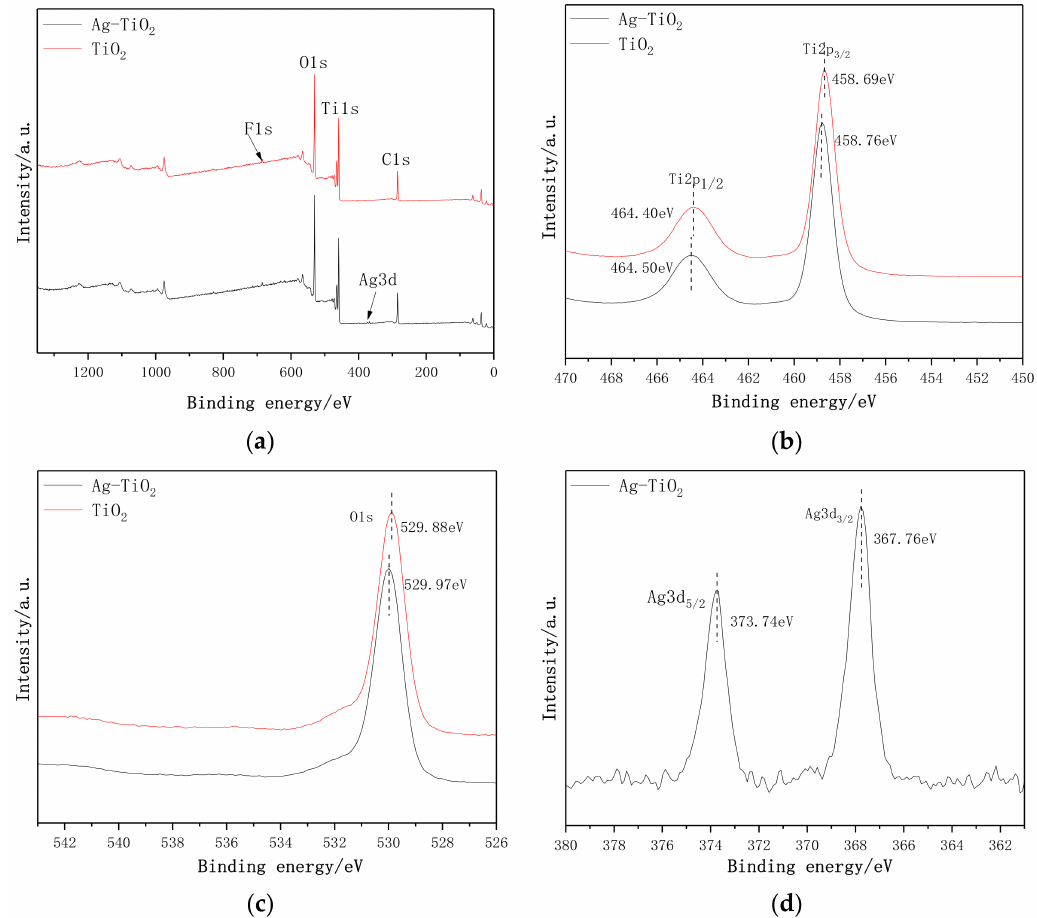
Figure 6. XPS spectra of pure TiO 2 and Ag-TiO 2 ( a ) Survey, ( b ) Ti 2p peaks, ( c ) O 1s peaks, and ( d ) Ag 3d